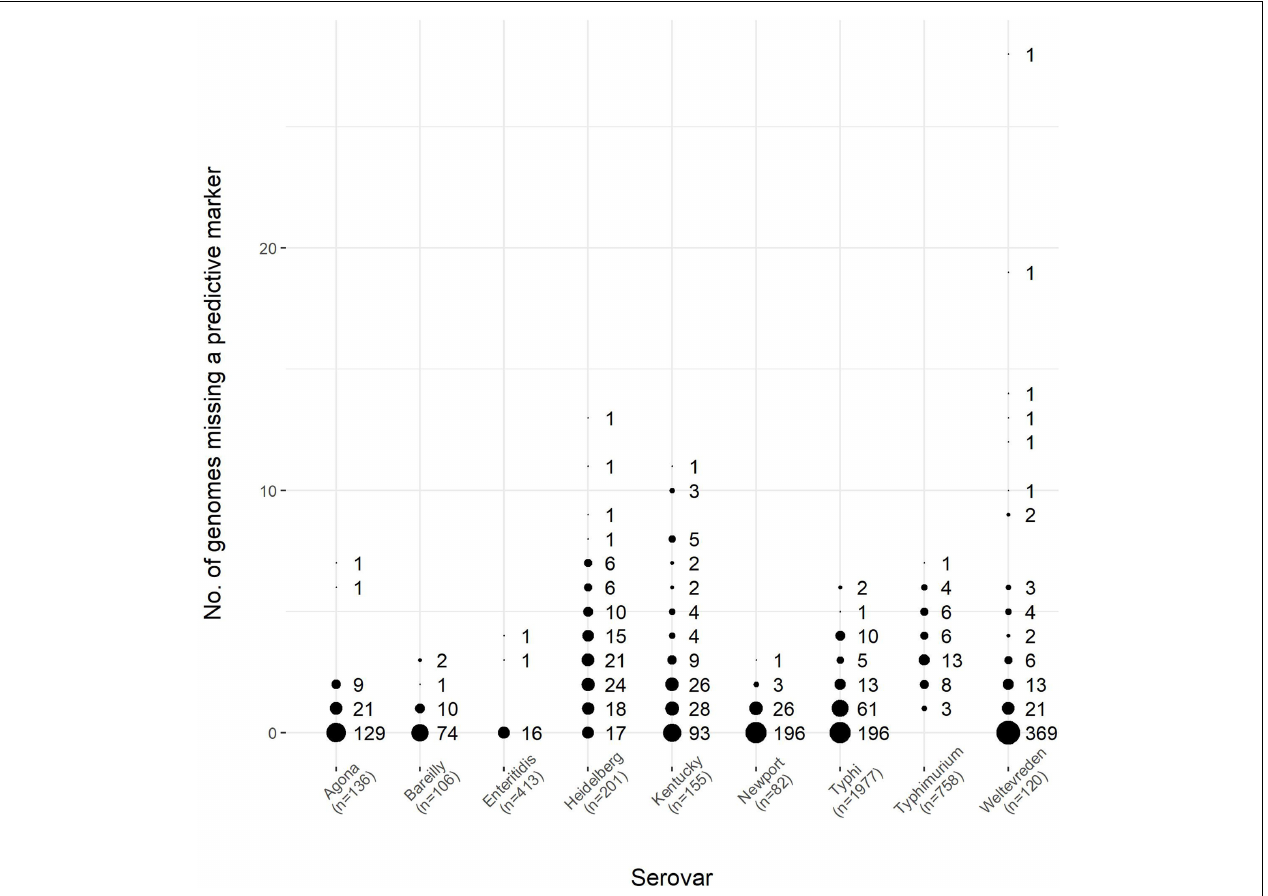
FIGURE 7 | The number of predictive markers from the GenBank dataset found within the EnteroBase dataset for nine serovars of S. enterica , which encompassed a test set of 3948 genomes. The number of genomes for each serovar was the same between the GenBank and EnteroBase datasets, as shown in Table 6 . The size of the circles is proportional to the number of predictive markers from the GenBank dataset found in the EnteroBase dataset. The number of genomes for each serovar is given in the horizontal axis label. Using serovar Agona as an example, there were 136 genomes in both the GenBank and EnteroBase datasets, and 129 of the 161 predictive markers from the GenBank dataset were found in all of the genomes from the EnteroBase dataset, whereas 21 of the GenBank predictive markers were found in all but one (135) of the EnteroBase genomes